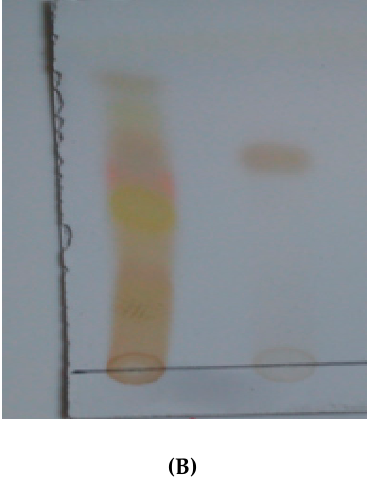
Figure 6. (A) FT-IR (Fourier-transform infrared) spectrum of the CFL-1 fraction of C. fistula leaves; (B) Plate I: thin layer chromatography of fractions from C. fistula (Solvent system-CHCl 3 :MeOH 9:1).